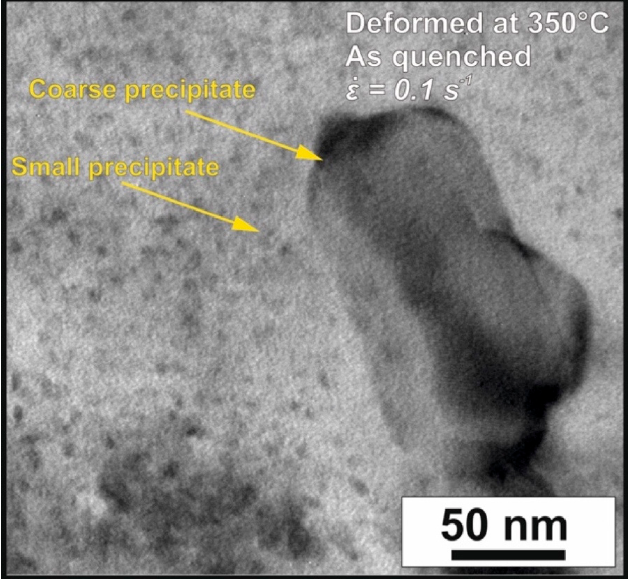
Figure 8. TEM micrograph of the formed microstructure at the deformation temperature of 𝑇 (cid:3005)(cid:3021) (cid:3404) 200 °C and strain rate of 𝜀(cid:4662) (cid:3404) 0.1 s (cid:2879)(cid:2869) of the as ‐ quenched condition. Figure 9a,b show the microstructure of both conditions at the deformation tempera ‐ ture of 𝑇 (cid:3005)(cid:3021) (cid:3404) 350 °C and strain rate of 𝜀(cid:4662) (cid:3404) 10 s (cid:2879)(cid:2869) . For the TSM microstructure, lath ‐